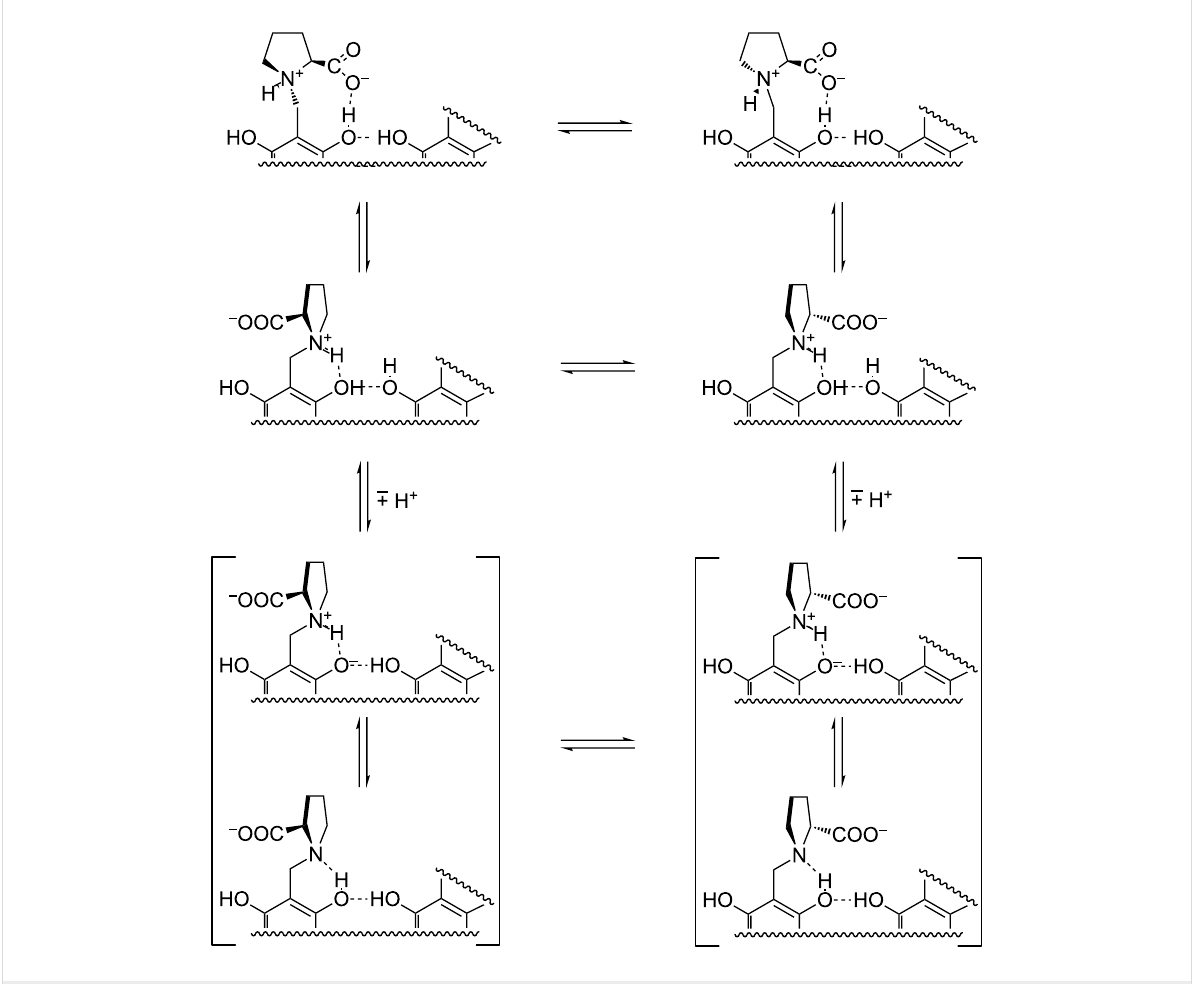
Figure 4: Structural models for the conformational rearrangements of CAP.